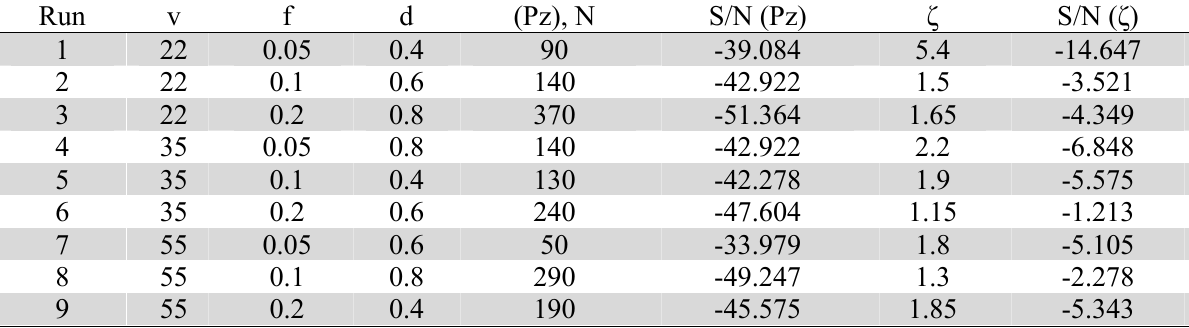
Experimental results and corresponding S/N ratios for Pz and